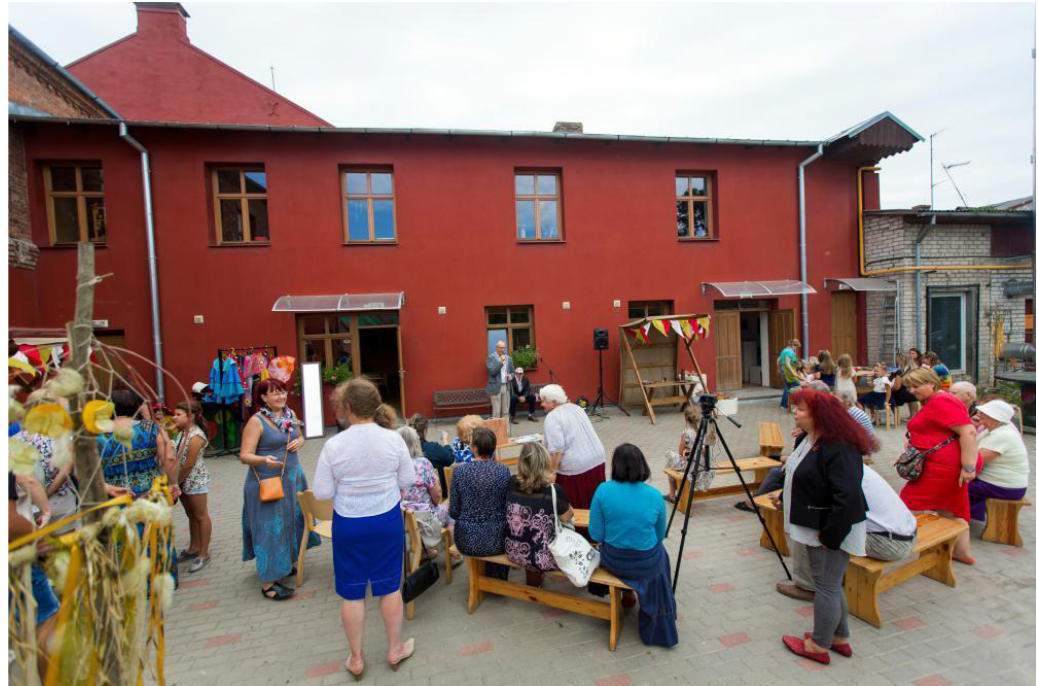
Figure 6. Festival of courtyards in Bauska’s Old Town. Source: Namiķis